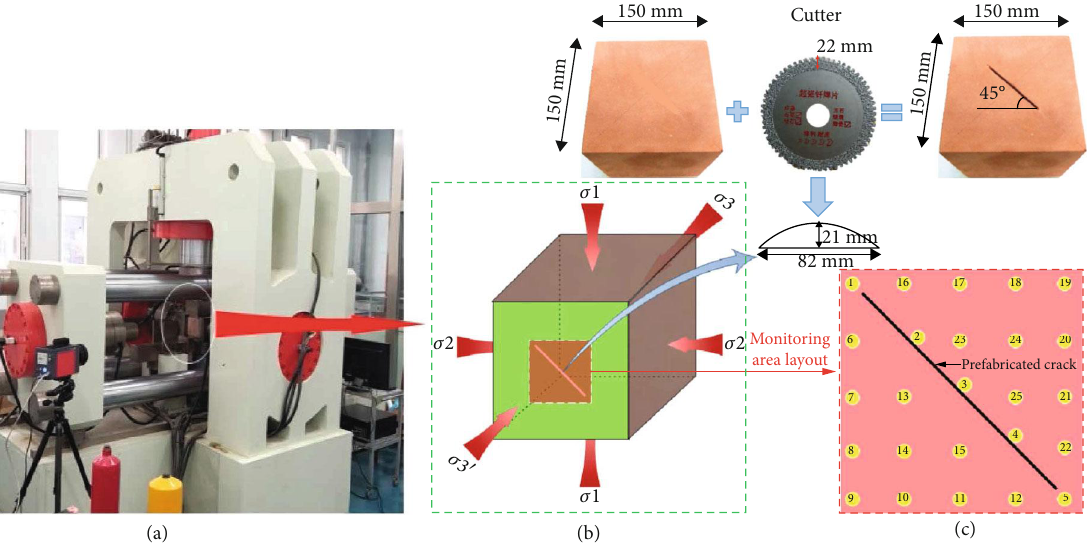
Figure 2: Distribution diagram of the prefabricated fi ssure and selected monitoring regions on red sandstones